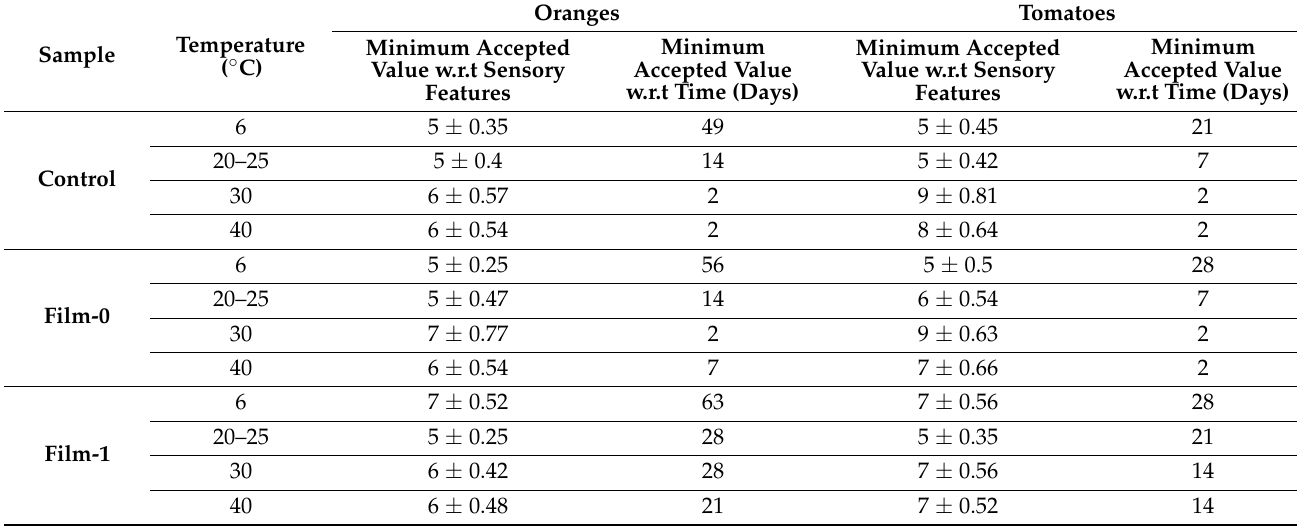
Figure 8. The photographs of uncoated oranges (control), BC-coated oranges (Film-0), and BC/CMC/Gly/yeast-coated oranges (Film-1) stored at ( A ) 30 ◦ C, ( B ) 40 ◦ C, ( C ) 6 ◦ C, and ( D ) room temperature (20 to 25 ◦ C) for different time intervals. Table 3. Values of the acceptability degree of oranges and tomatoes for uncoated (control), BC-coated (Film-0), and BC/CMC/Gly/yeast-coated (Film-1) under different storage conditions, including at 6 ◦ C, 30 ◦ C, 40 ◦ C, and room temperature (20 to 25 ◦ C), for a different time